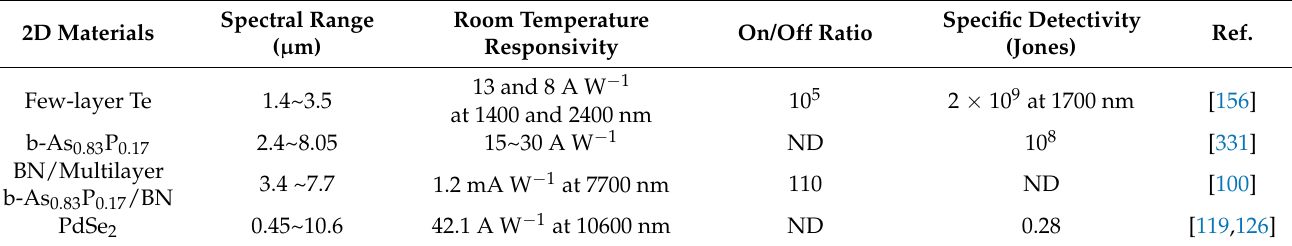
Table 4. The 2D material candidates for LEDs operation.